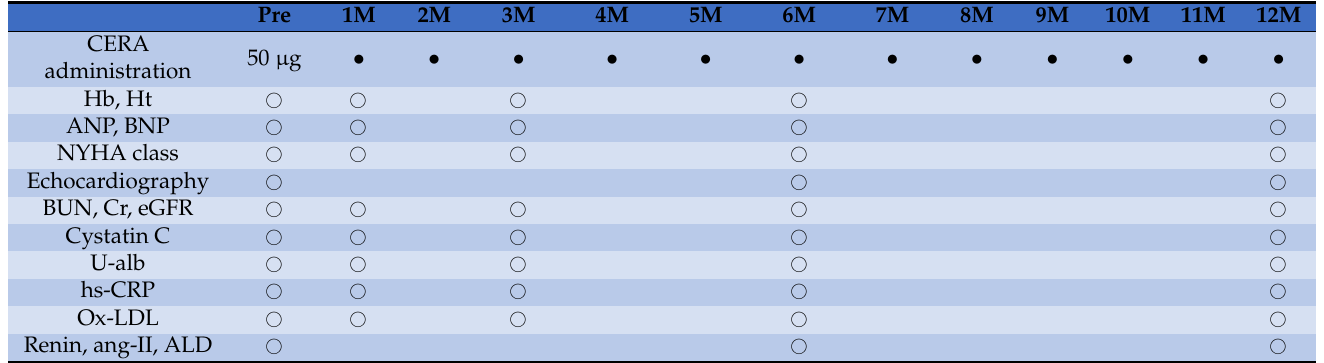
Table 1. Dosing method and the timing of each